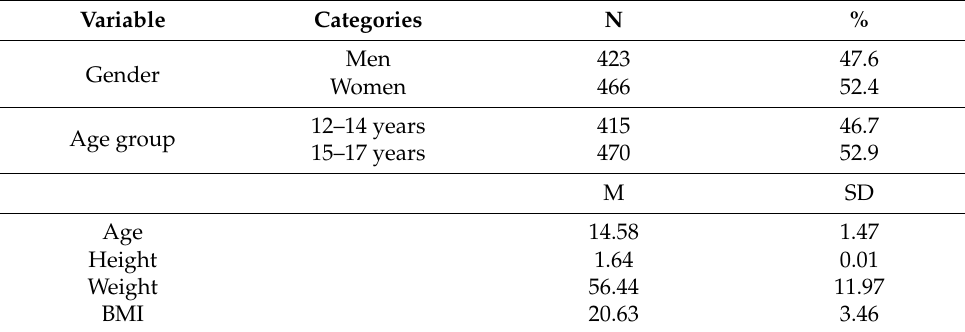
Table 1. Characterization of the sample (N = 889). Variable